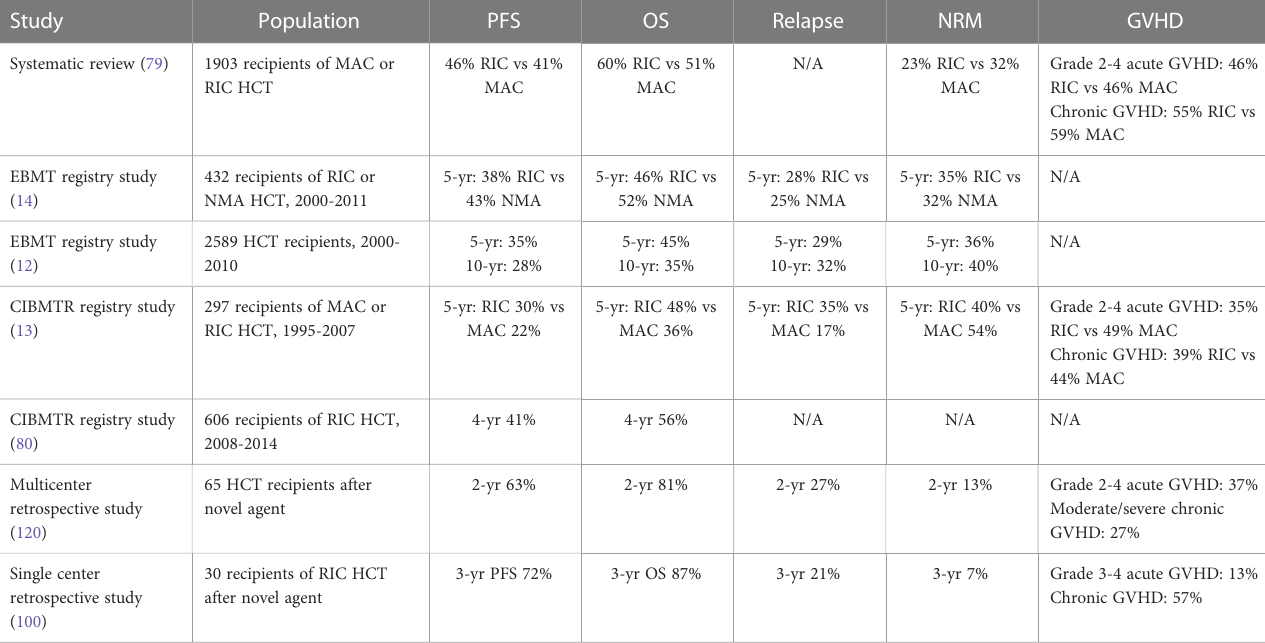
TABLE 2 Outcomes of allogeneic HCT for CLL from representative studies.